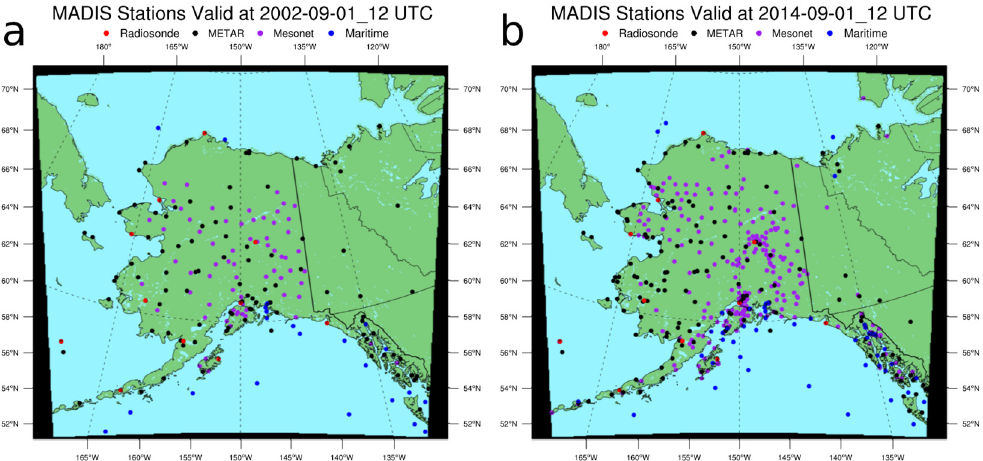
Figure 2. Maps of the MADIS observation station locations by network (red = radiosonde, black = METAR, purple = mesonet, and blue = maritime) that were used for validating the WRF simulations, valid at ( a ) 1 September 2002/12 UTC, and ( b ) 1 September 2014/12 UTC.